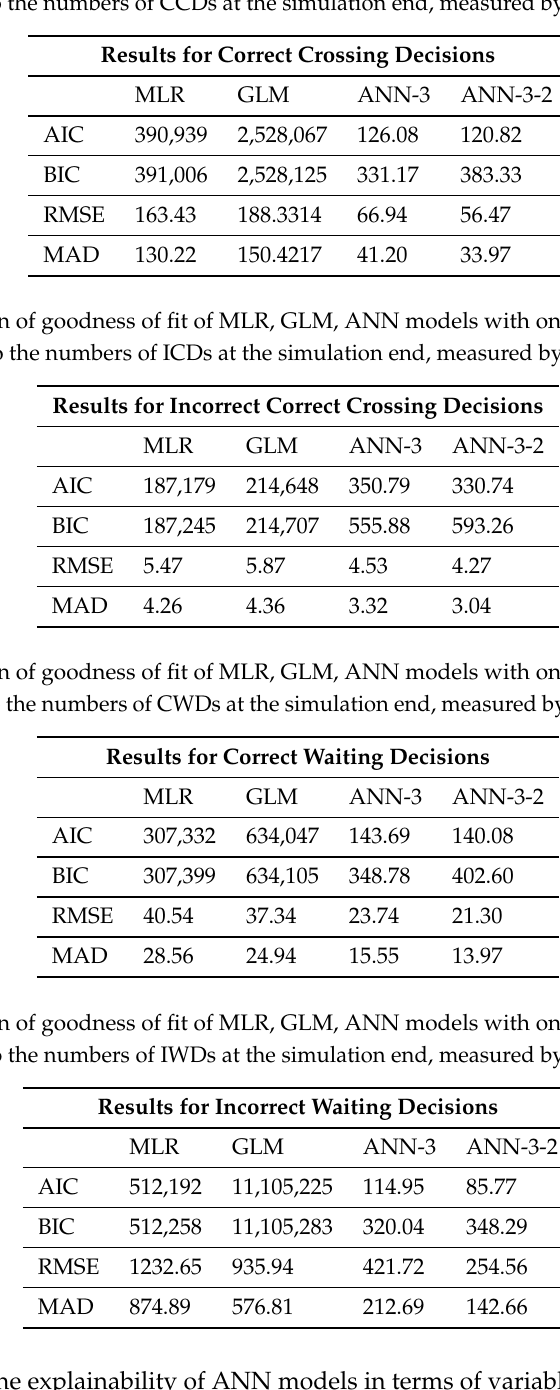
Table 1. Comparison of goodness of fit of MLR, GLM, ANN models with one hidden layer and with two hidden layers to the numbers of CCDs at the simulation end, measured by AIC, BIC, RMSE, MAD.